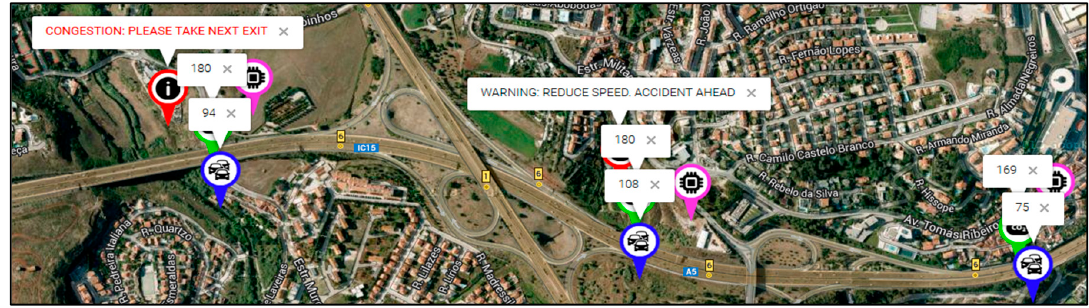
Figure 7. Alert messages received by the user: fragment of the demonstrator web application.